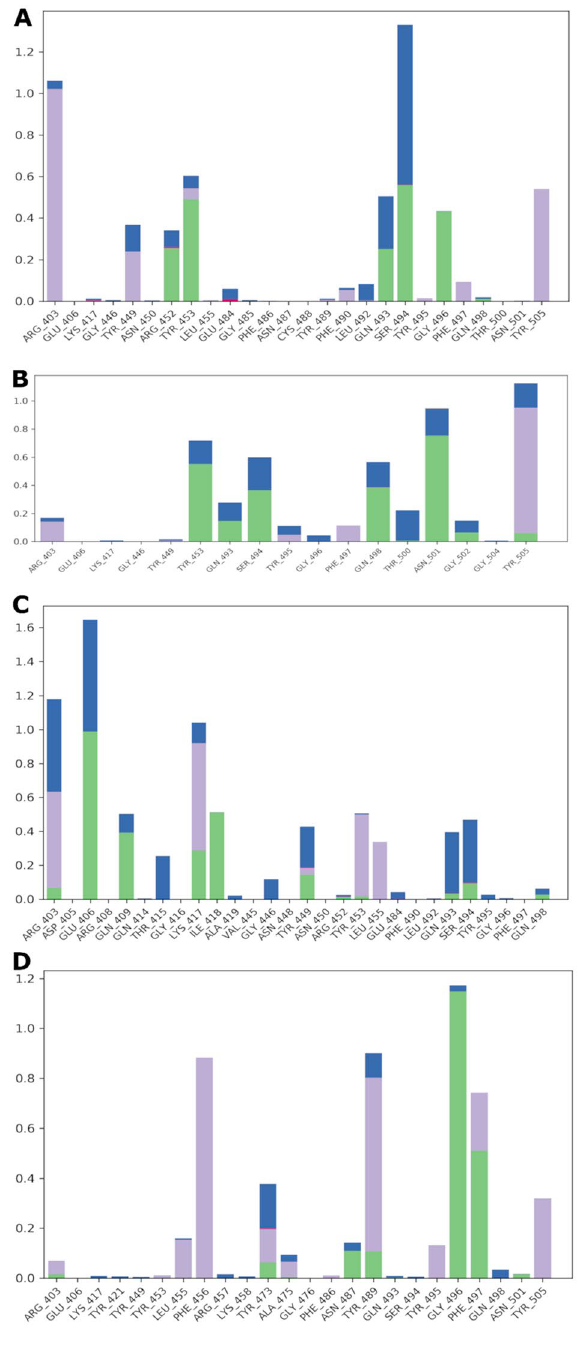
Figure 7. Spike RBD interactions with compounds #2 ( A ), #4 ( B ), #15 ( C ), #17 ( D ) monitored throughout the simulation trajectories. The interactions are clustered by type and shown in bar diagram including H-bonds (green), hydrophobic (light purple), ionic (pink) and water bridges